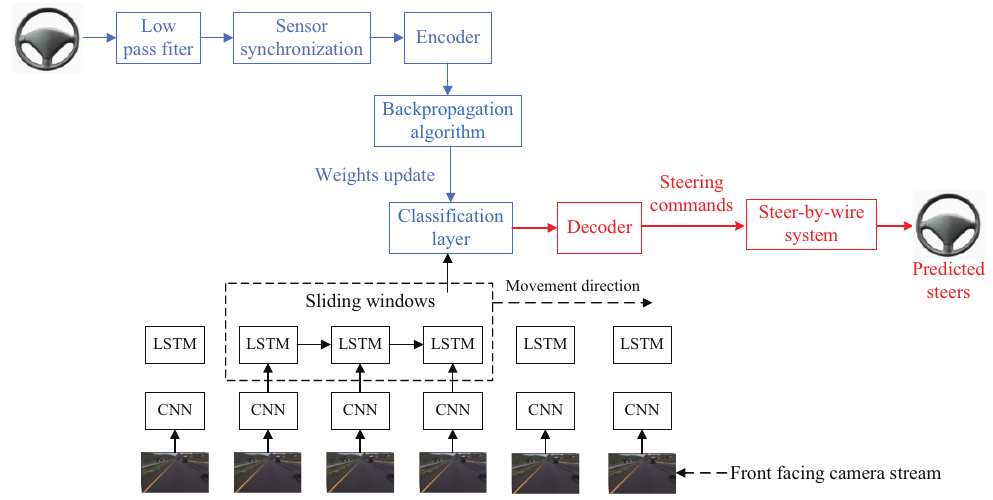
Figure 19. A overview of the block diagram of the system proposed in